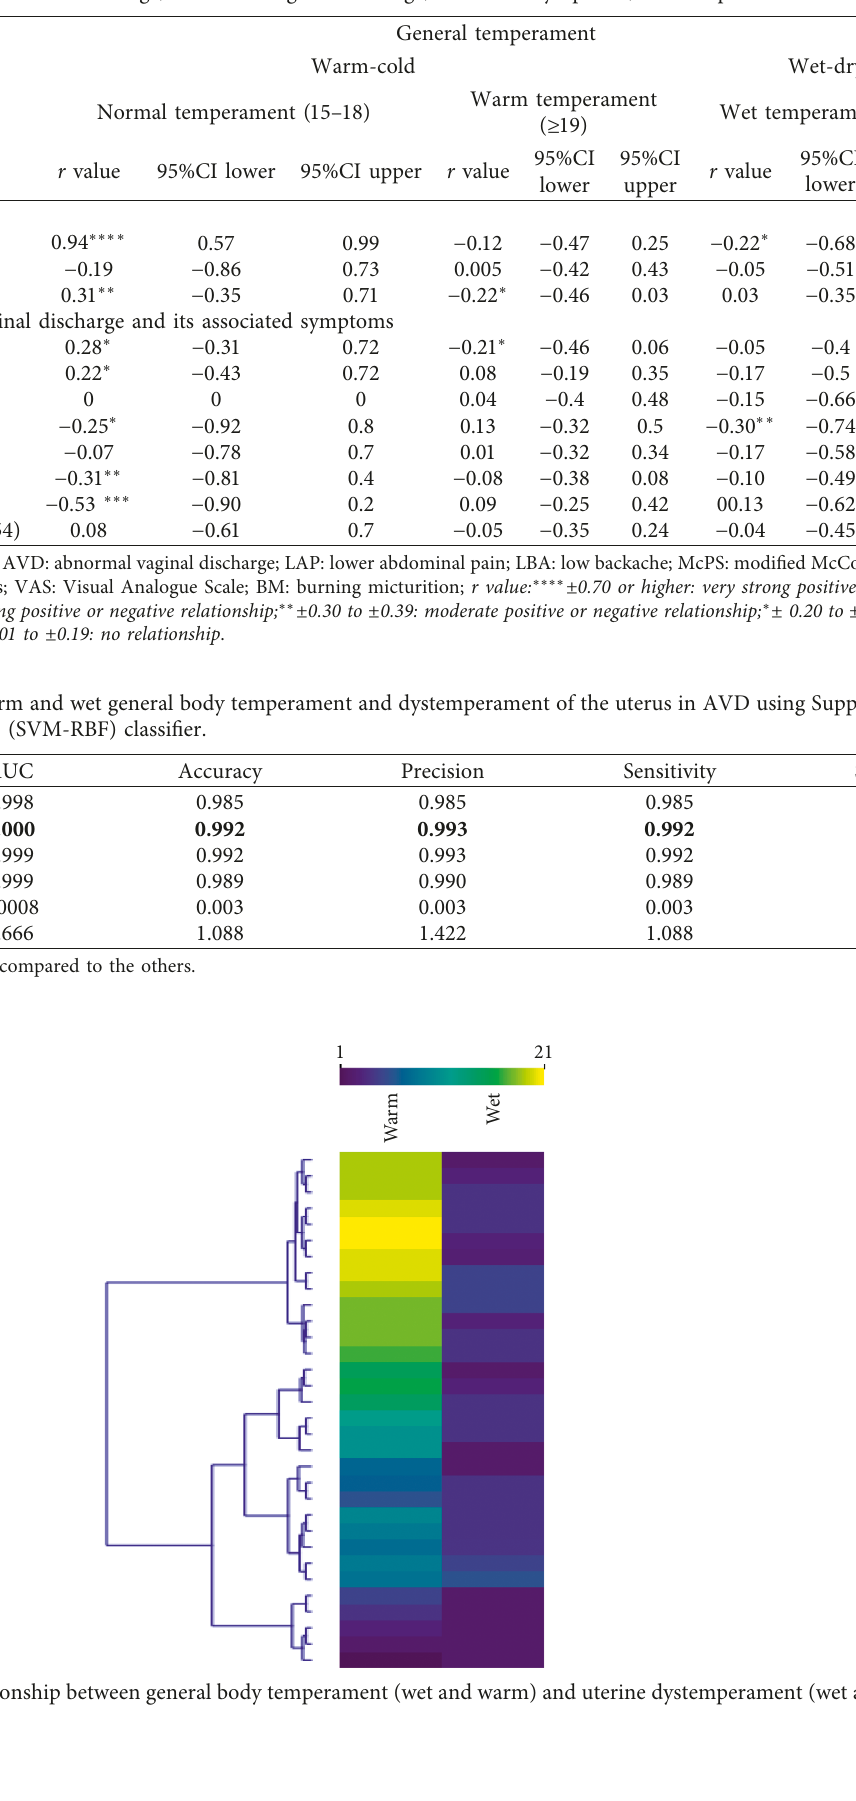
Table 5: Correlation between age, abnormal vaginal discharge, associated symptoms, and